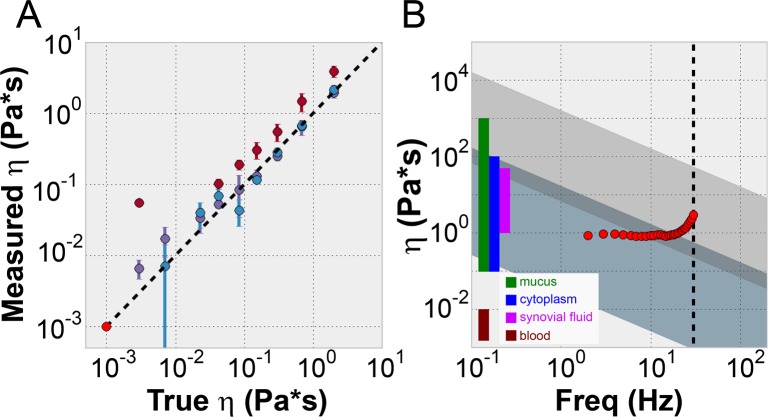
ASAP viscometry.(A) Correlation plot between the measured viscosity and true viscosity of sucrose and Karo solutions. The true viscosity was measured using a cone and plate rheometer, while the measured viscosity was determined from ASAP measurements and the ASAP-2 model using Sp < 1 conditions. Water was used as the calibration fluid (bright red circle). The colors of the data points represent different post array samples (different experimental trials). Three trials are represented (dark red, purple and blue). (B) Plot showing the experimental range of our current experimental set up (dark blue-gray region), and a proposed alternate design with a 3 um radius and a Ni shell that is ¾ the length of the post (light grey). The red circles represent experimental data taken over a range of frequencies (and a corresponding range of Sp) for a particular viscous sample (nominal 2 Pa*s) using the ASAP system. These viscosity measurements are consistent for Sp < 1, but deviate as experimental conditions pass through Sp = 1. The black dashed line is the frequency limit of our amplifier. Colored regions on the left represent the low frequency viscosity ranges of biofluids that may be of experimental interest using our ASAP system [47–50].